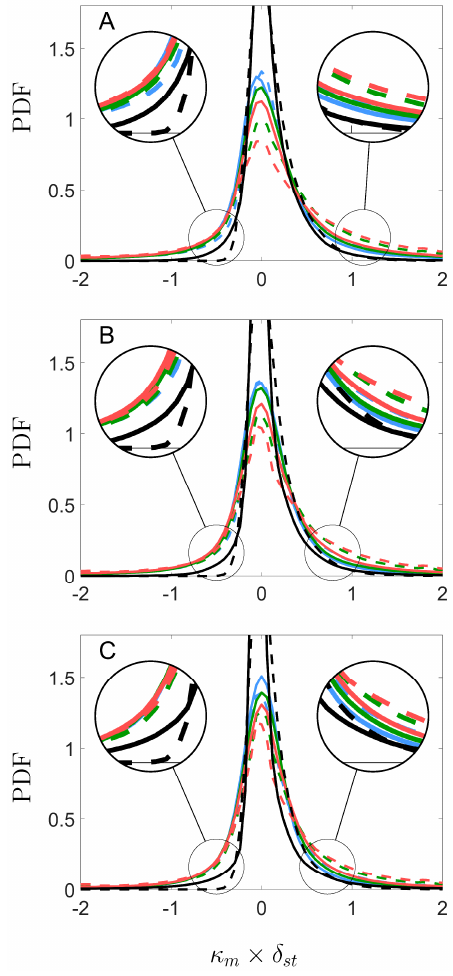
Figure 7. PDFs of 𝜅 (cid:3040) × 𝛿 (cid:3046)(cid:3047) of the 𝑐 = 0.8 isosurface at locations A, B and C (top to bottom) for gaseous premixed ( ) and V-shaped spray flames with initial 𝑎 (cid:3031) 𝛿 (cid:3046)(cid:3047) ⁄ = 0.04 ( ), 0.05 ( ) and 0.06 ( ) for 𝑢 (cid:3040)(cid:3032)(cid:3028)(cid:3041) 𝑆 (cid:3029),(cid:3046)(cid:3047) ⁄ = 5.0 (continuous line) and 10.0 (dashed line). The y -axis ), 0.05 ( ) and 0.06 is shown in log-scale.